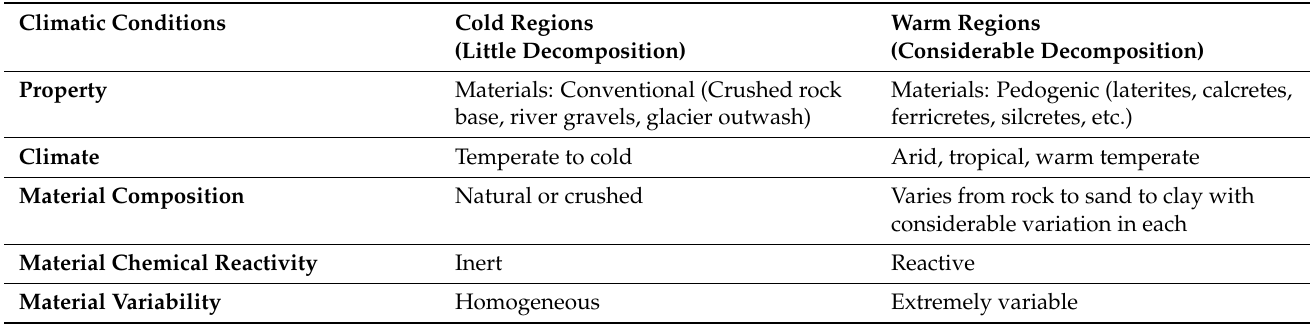
Table 1. Generalised material properties associated with different climatic regions of the world due to the effect of chemical weathering (based on